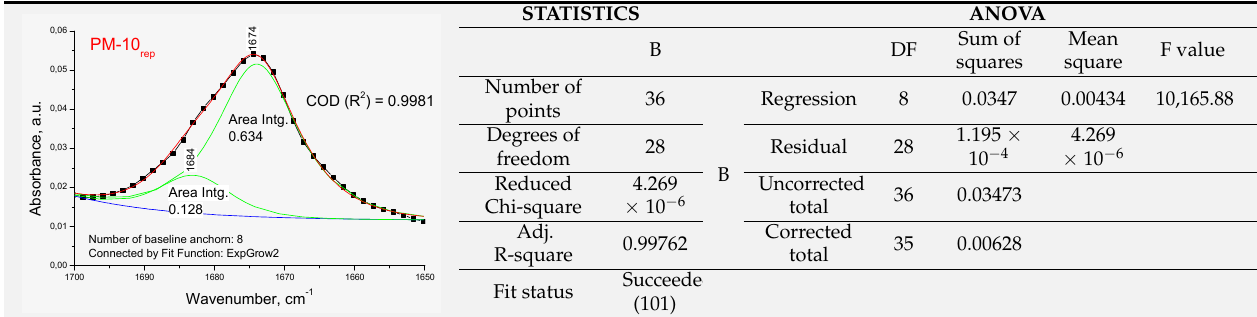
Table A7. Sample P-10 rep.